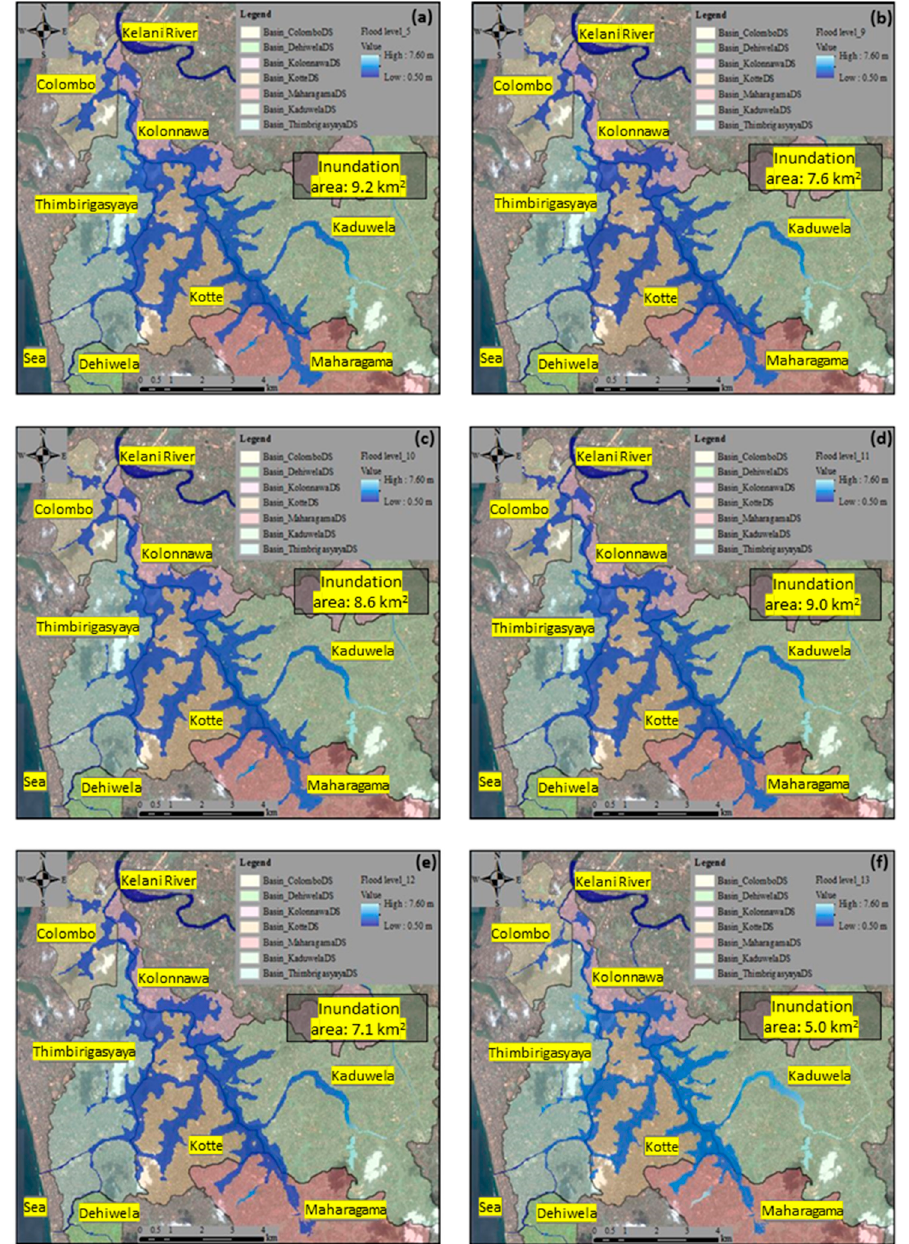
Figure 13. Comparison of the impact of the introduced countermeasures, inundation maps for ( a ) existing condition; ( b ) with Gothatuwa diversion canal; ( c ) with St-Sebastian south canal; ( d ) with Mutwal diversion; ( e ) with Madiwela south diversion; ( f ) with all four countermeasures.